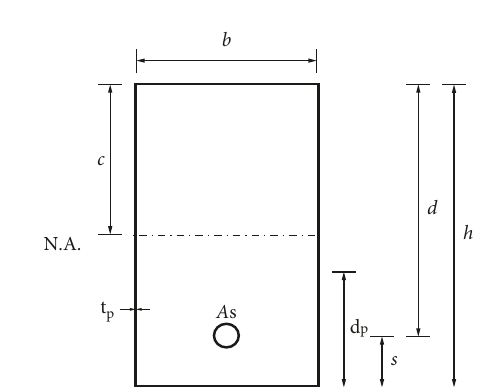
Figure 7: GFRPU-reinforced concrete beam.